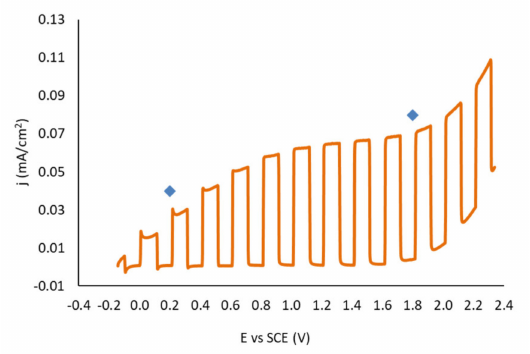
Figure 1. LSV of TiO 2 -NT performed at 10 mV s − 1 of scan rate, under dark and irradiation condition. Blue symbols indicate the potentials selected for the degradation runs.